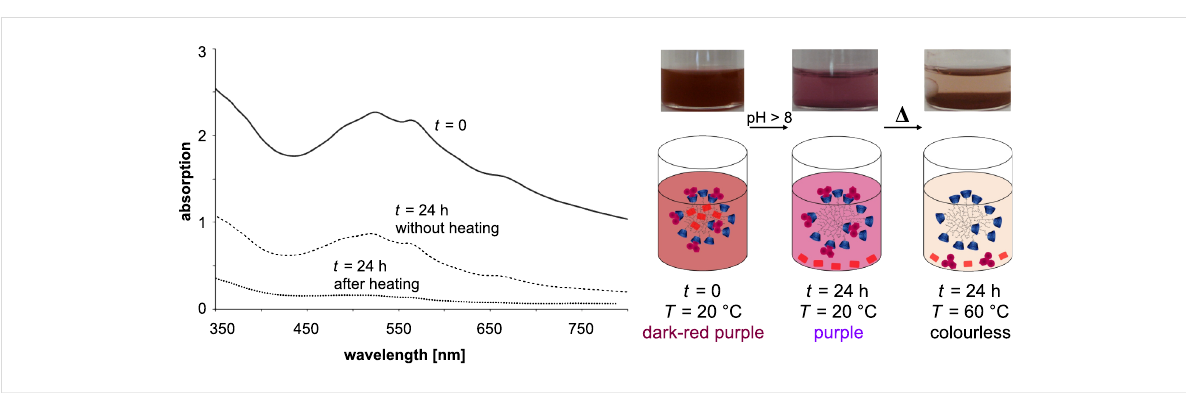
Figure 4: UV–vis spectra of complex 6 in basic solution (pH 10) before heating (solid line), after 24 h without heating (dashed line) and after 30 min of heating at 60 °C (dotted line), and corresponding photos and schematic illustrations of the